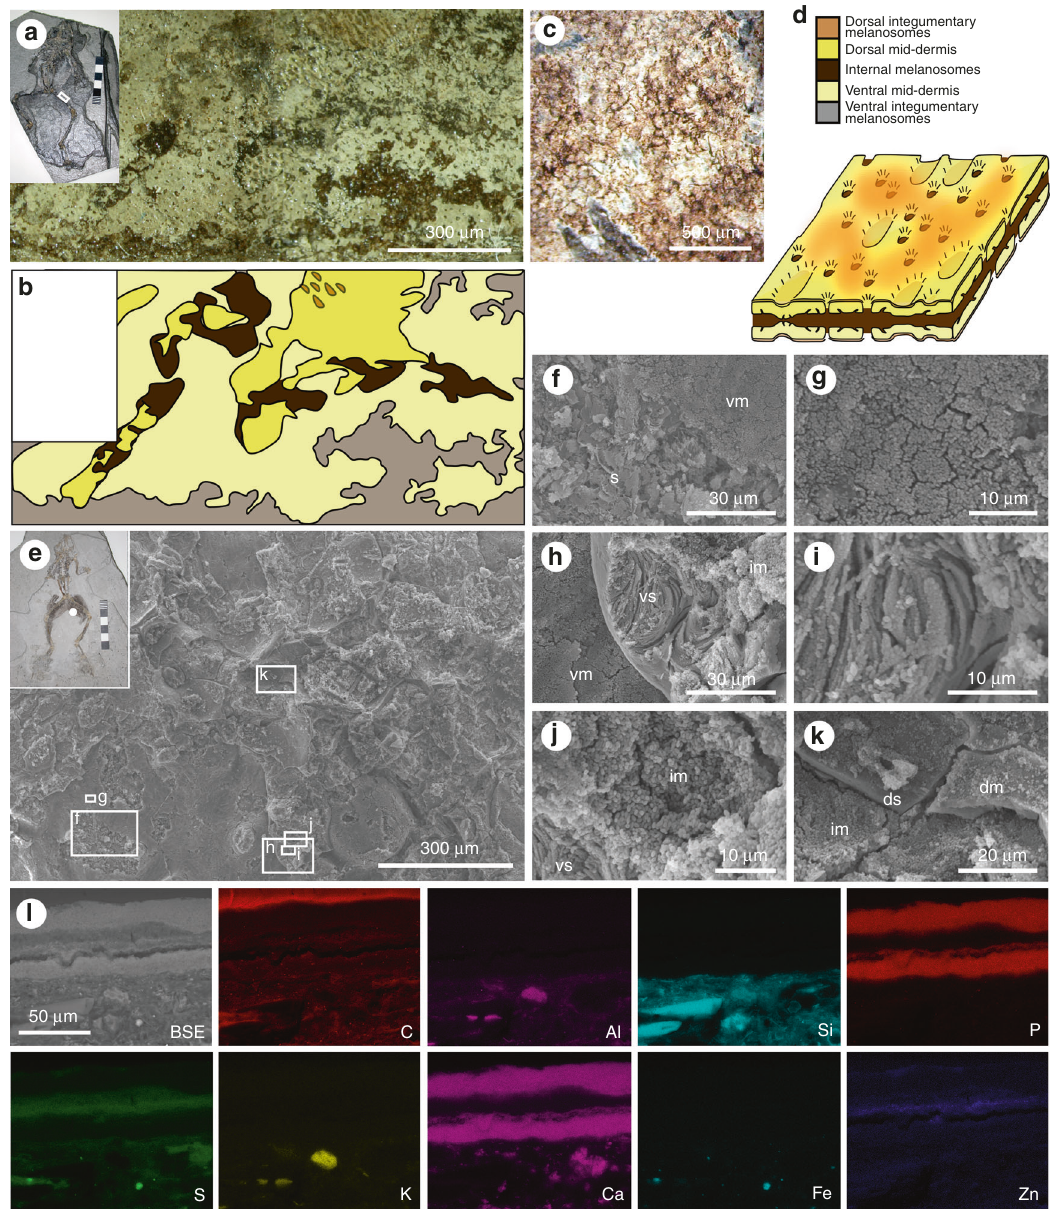
Fig. 4 Layered soft tissues in the hindlimbs of fossil frogs from Libros. a – b MNCN 63775. Light micrograph of area indicated in inset, showing a plan view of the soft tissues in the thigh. b Interpretative drawing of soft tissue layers present, based on light microscopy. c Patterning in the integumentary melanosome layer. d Three-dimensional schematic illustration of the preserved 3D structure of the layered soft tissues in the Libros frogs, based on data presented in ref. 12 and this fi gure. The terms ‘ dorsal ’ and ‘ ventral ’ are for illustrative purposes only. e – l MNCN 63798. e Scanning electron micrograph of soft tissues from the region indicated in the inset. f – k Details of regions indicated in e . f Sediment (s) underlying the ventral melanosome layer (vm). g Detail of ventral melanosomes. h Ventral layer of phosphatized skin (vs) overlain by non-integumentary melanosomes (im) and underlain by ventral melanosomes. i Detail of collagen fi bres of phosphatized skin. j Detail of non-integumentary melanosomes. k Dorsal layer of phosphatized skin (ds) overlain by dorsal melanosome layer (dm). l Elemental maps of polished sections through the soft tissues from the thigh. Melanosome layers are de fi ned by C, S and Zn. SE: secondary electron micrograph of region analysed, dm: dorsal melanosome layer, s: sediment, vm: ventral melanosome layer, vs: ventral skin layer. Scale bars, 300 μ m ( a ), and same scale in b , 500 μ m ( c ), 300 µ m ( e ), 30 µ m ( f , h ), 10 µ m ( g , i , j ), 20 µ m ( k ), 50 μ m ( l